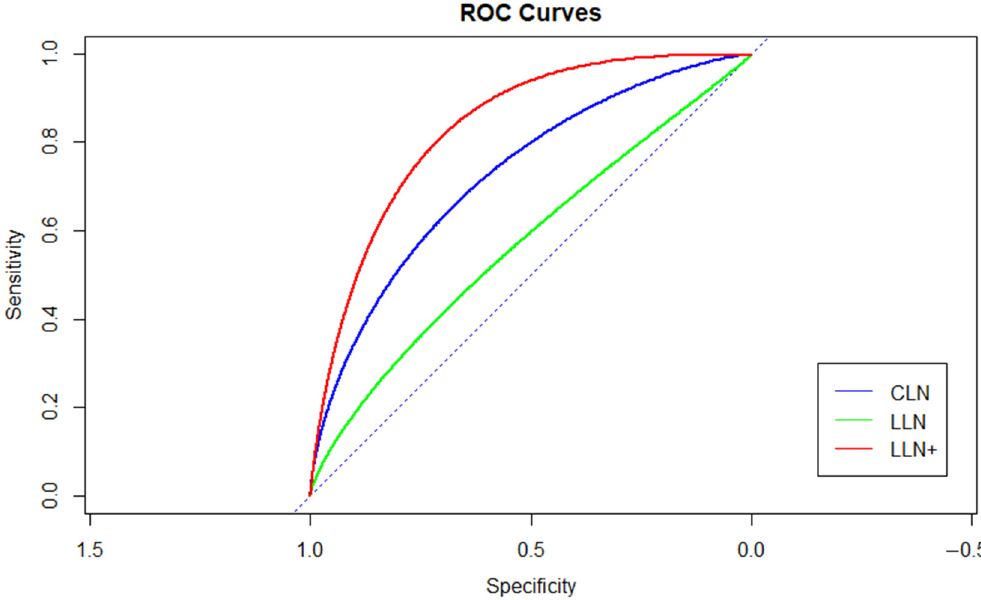
Figure 1. The number of LLN is a poor predictor of CLN+ ≥